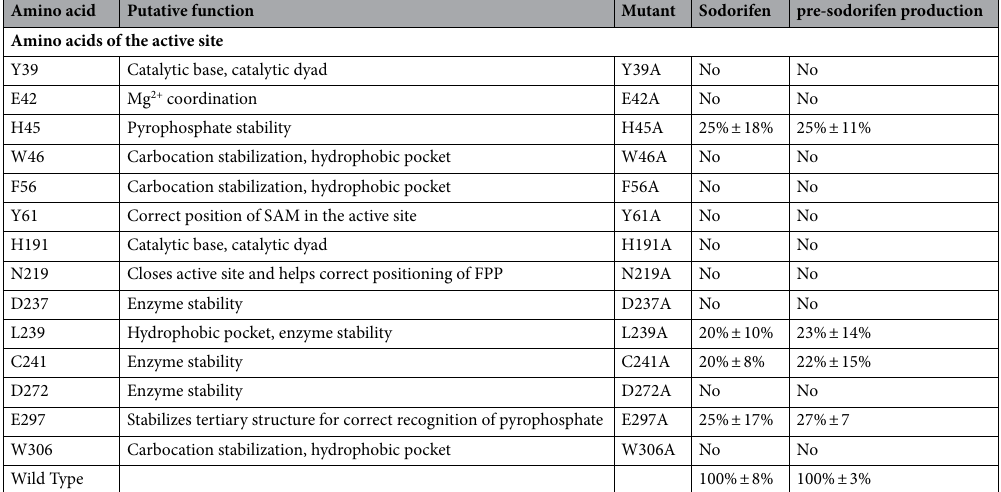
Table 1. GC–MS analysis of the enzyme assay products. Double (for sodorifen production) or coupled enzyme assays (for pre-sodorifen) were performed with wildtype and mutant FPP C -methyltransferase of Serratia